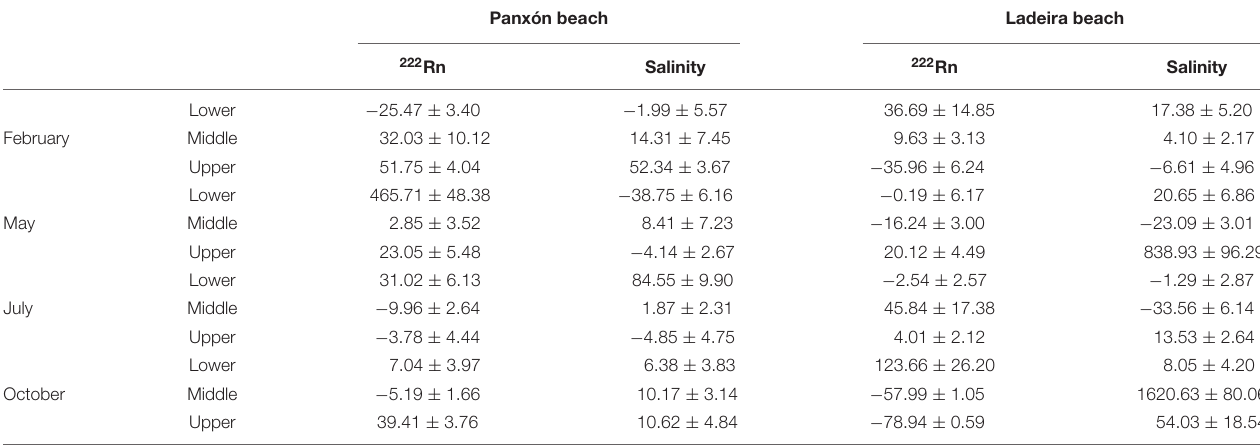
TABLE 2 | Apparent percentage of change (%) between the integrated concentrations of dissolved inorganic nitrogen (DIN = NH 4 + + NO 2 − + NO 3 − ) and the integrated concentrations of the conservative mixing DIN profiles using 222 Rn activities and salinity as conservative